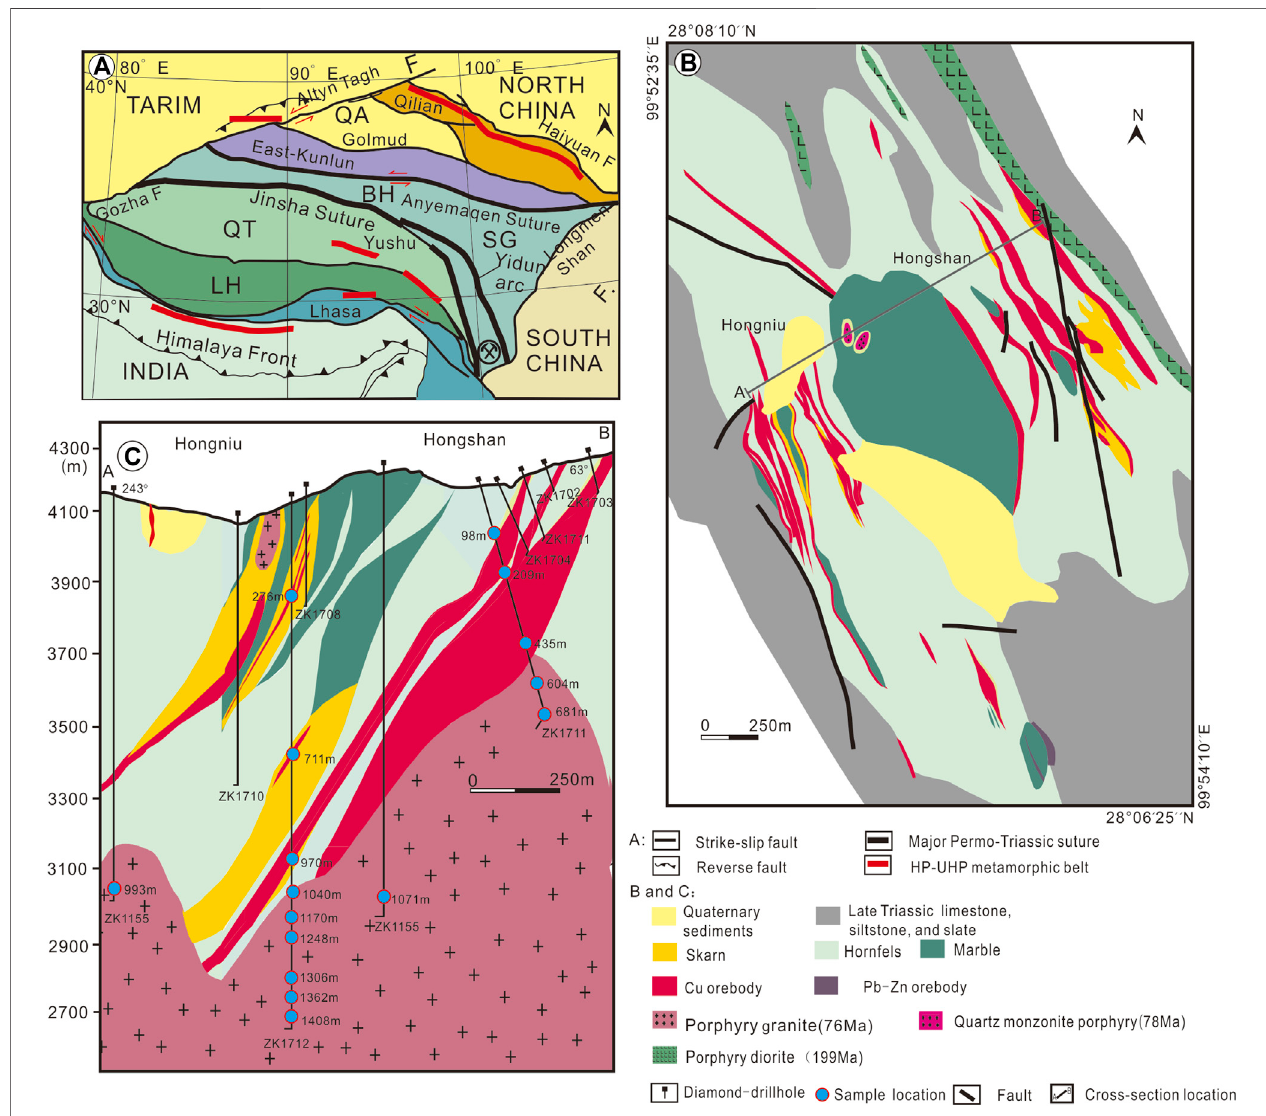
FIGURE 1 | Geological maps showing (A) the tectonic setting of the Yidun Arc and Hongniu – Hongshan copper deposit (Xiong et al., 2014), (B) the Hongniu – Hongshan Cu deposit (Peng et al., 2021), and (C) simpli fi ed cross sections through the Hongniu – Hongshan Cu deposit, showing the spatial relationship between the different rock types and ore bodies. The locations of the cross sections are shown in panel B. The samples analyzed in this study were all collected from cross sections A – B. LH = Lhasa Block; QT = Qiangtang Block; BH = Bayan Har terrane; QA = Qaidam Basin; S = Suture; F = Fault.